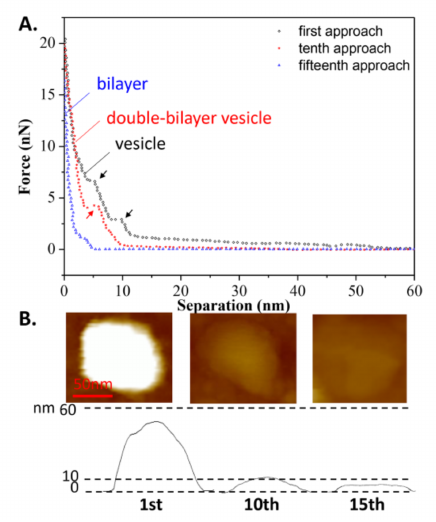
Figure 6. ( A ) The continuous approach curves of the DPPC vesicle obtained at T 2 = 25 ◦ C. The arrows refer to jumps occurring when the tip penetrates the bilayers; ( B ) AFM images before each approach.